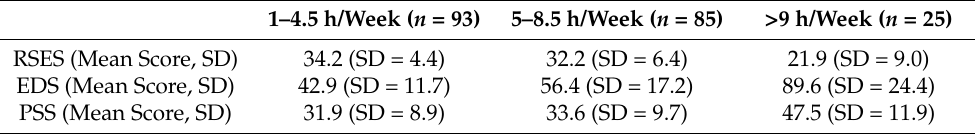
Table 3. Between-group differences in self-esteem, stress, and exercise-dependence